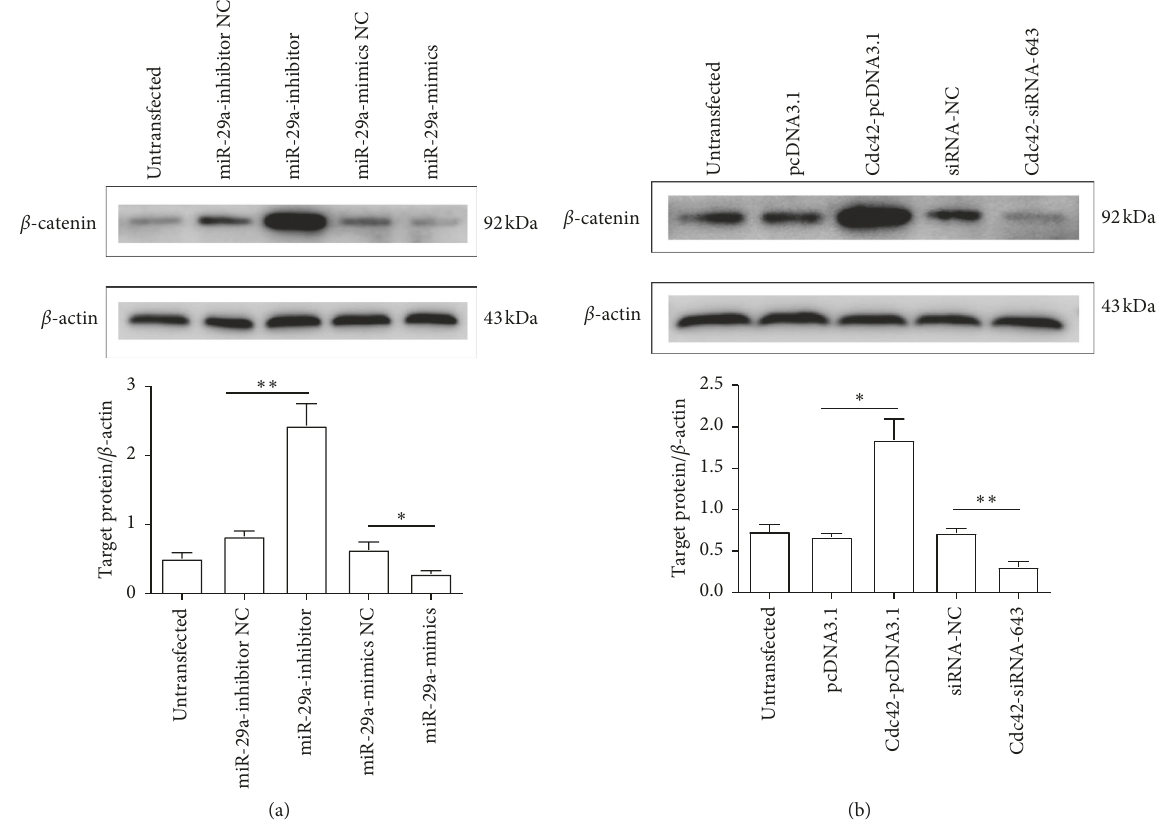
Figure 4: Effects of miR-29a and Cdc42 on β -catenin expression. (a) Effects of miR-29a on β -catenin expression. Western blot to detect β -catenin expression after transfection with miR-29a mimic and inhibitor ( n � 3). ∗ P < 0 . 01, compared with miR-29a mimic NC, and ∗∗ P < 0 . 01, compared with miR-29a inhibitor NC, as assessed by paired Student’s t -test. (b) Effects of Cdc42 on β -catenin expression. Western blot to detect β -catenin expression after transfection with Cdc42-pcDNA3.1 and siRNA-643 ( n � 3). ∗ P < 0 . 01, compared with pcDNA3.1, and ∗∗ P < 0 . 01, compared with siRNA-NC, as assessed by paired Student’s t -test. Data are shown as mean ± SD. NC: negative